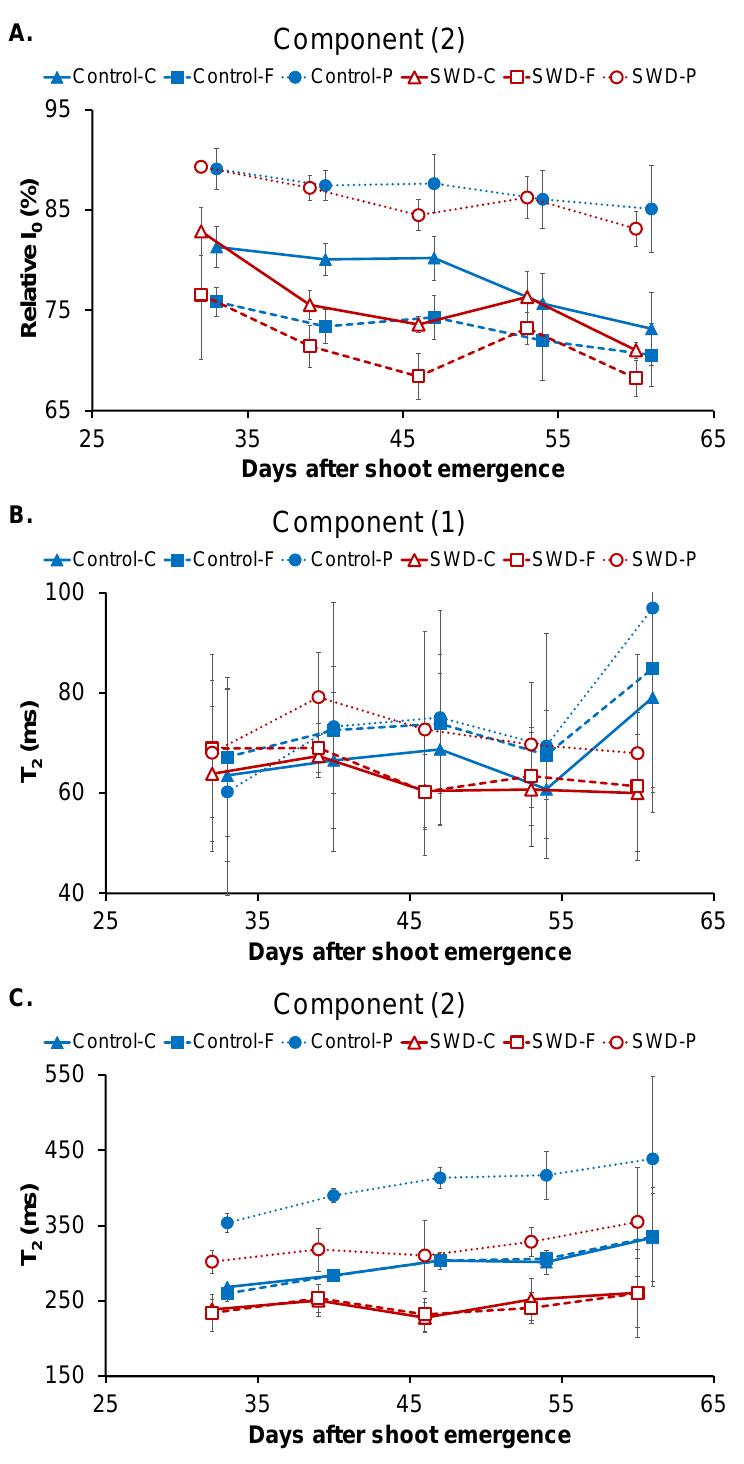
Figure 5. Evolution of ( A ) component (2) relative signal distribution, ( B ) component (1) transverse relaxation time (T 2 ) and ( C ) component (2) T 2 in potato tuber tissues (C: Cortex; F: Flesh; P: Pith) during tuber filling expressed in days after shoot emergence for both control and severe water deficit (SWD) conditions. Values correspond to the average of four observations ( n = 4) and standard deviation are indicated by the segment bars. The statistical significance of values between tissues, growth periods and water regimes is reported in Tables 4–6,